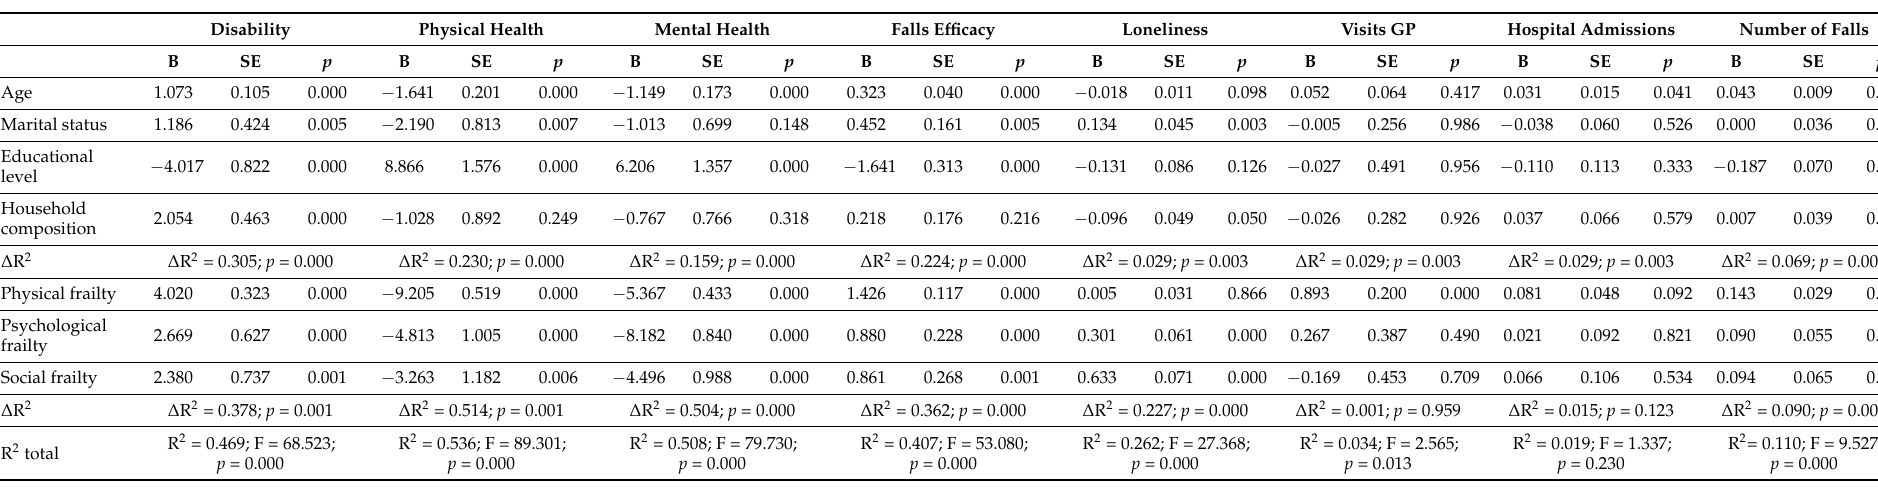
Table 3. CROSS-SECTIONAL Effects of Socio-demographic Characteristics and Frailty Domains on Adverse Outcomes: Linear Regression Analyses.